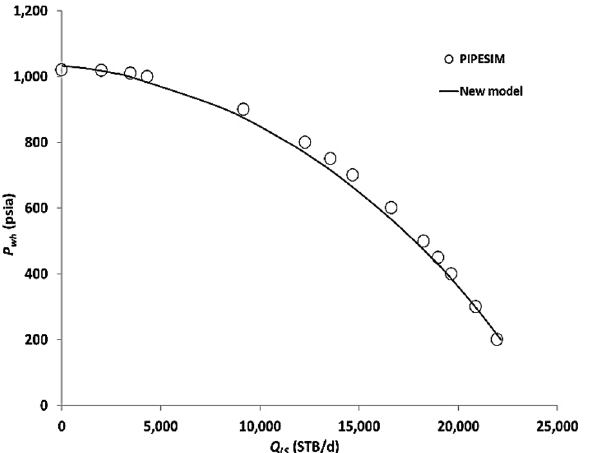
Fig. 5 Comparison of models for well B